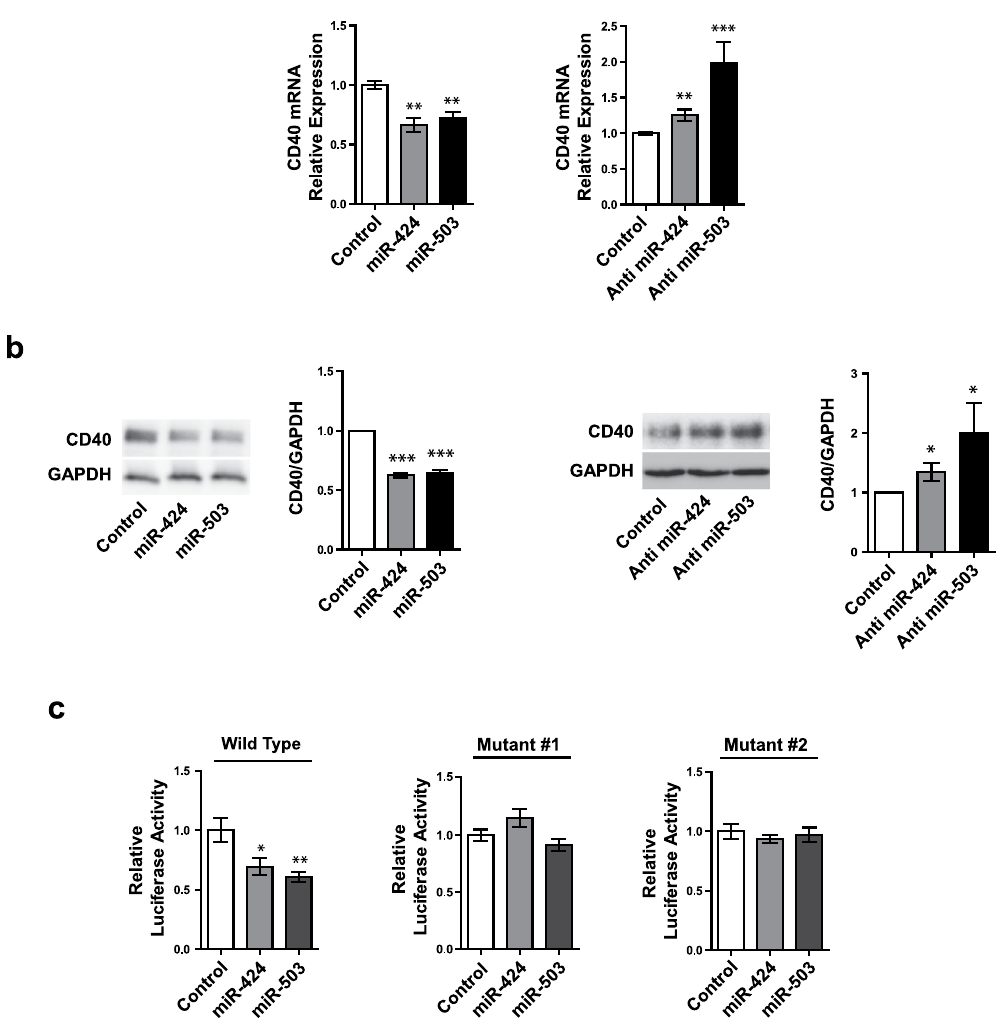
Figure 2. CD40 is regulated by miR-424 and miR-503 directly. ( a ) CD40 mRNA expression in response to overexpression of miR-424 or miR-503 mimics, or inhibition of miR-424 or miR-503 with anti-miRs in HUVECs. ( b ) CD40 protein expression in response to overexpression of miR-424 or miR-503 mimics or inhibition of miR-424 or miR-503 with anti-miRs in HUVECs. ( c ) Effect of miR-424 or miR-503 overexpression on luciferase reporter containing either the wildtype of mutagenized 3 ′ UTR of human CD40 gene in HeLa cells. Luciferase activity data for constructs with the wild-type (WT) and mutants (#1 and #2) 3 ′ UTR constructs are shown. * P < 0.05, ** P < 0.01, *** P < 0.001 compared to controls. Error bars, s.e.m. Cropped gel images are shown; uncut gels are included in the Supplementary